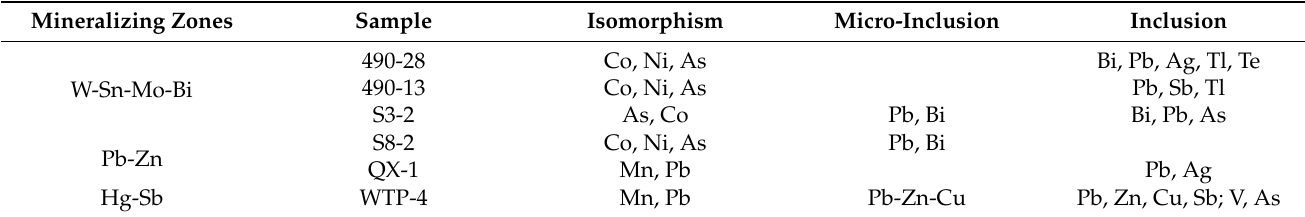
Table 5. The present forms of trace elements in